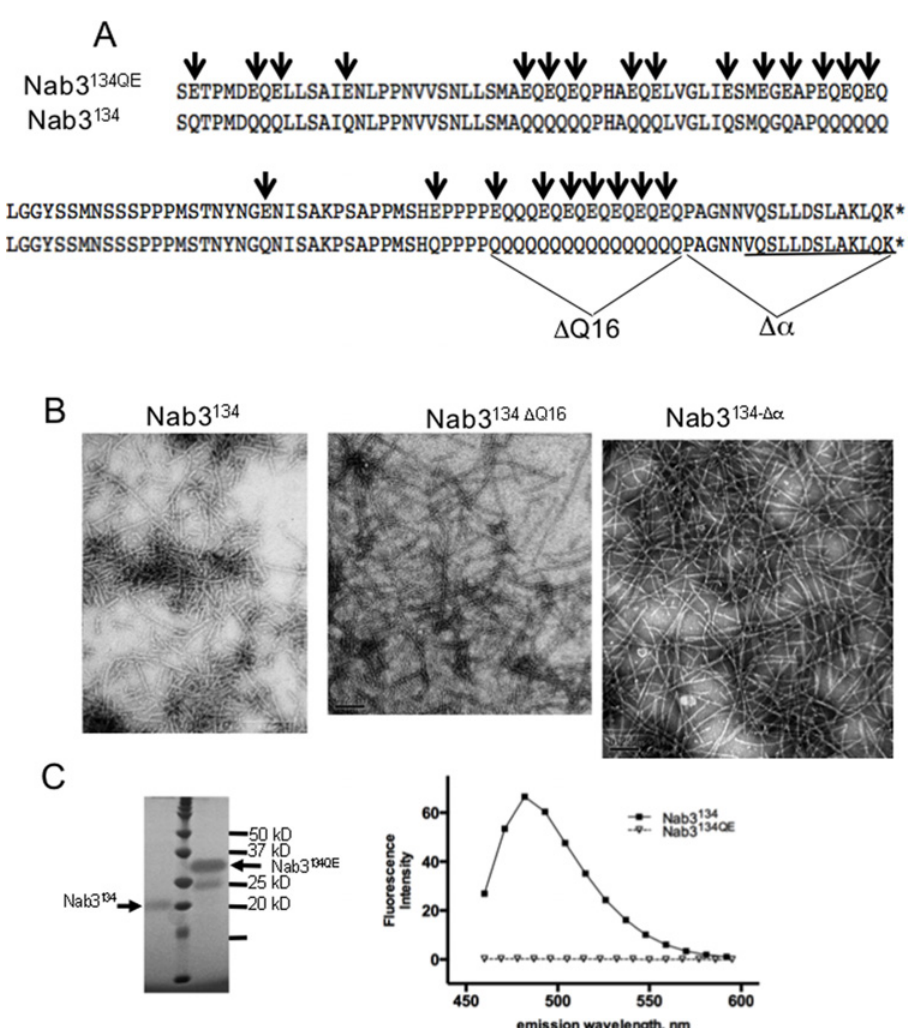
Fig 1. Filament formation by mutants of the LCD of Nab3. (A) A portion of the wildtype (Nab3 134 ) and glutamine to glutamate substituted (Nab3 134QE ) LCD of S . cerevisiae Nab3 is shown. The extent of the deletion of Q 16 run and the terminal hnRNP-C-like domain ( Δα ) are also shown. The region of Nab3 with structural homology to human hnRNP-C is underlined. (B) Transmission electron microscopy images of filaments from the various purified versions of Nab3 134 are shown. (C) Purified Nab3 134 and Nab3 134QE were run on a 12% SDS-PAGE gel (left panel) next to molecular weight markers and stained with Imperial TM stain (note this polypeptide binds Coomassie blue-based dyes poorly). Thioflavin T-binding and fluorescence (right panel) was measured for Nab3 134 and Nab3 134QE as described in Materials and